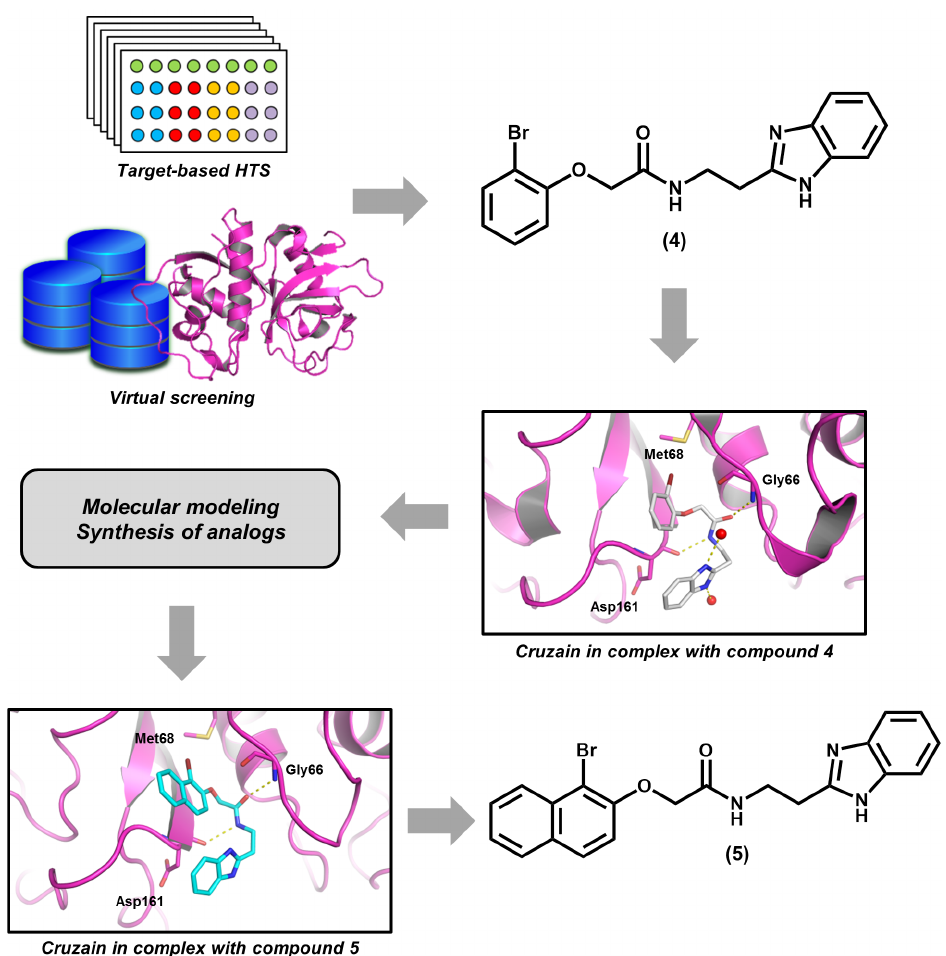
Figure 3 - Integration of target-based high-throughput screening (HTS), molecular modeling and structure-activity relationship (SAR) studies for the discovery of novel reversible cruzain